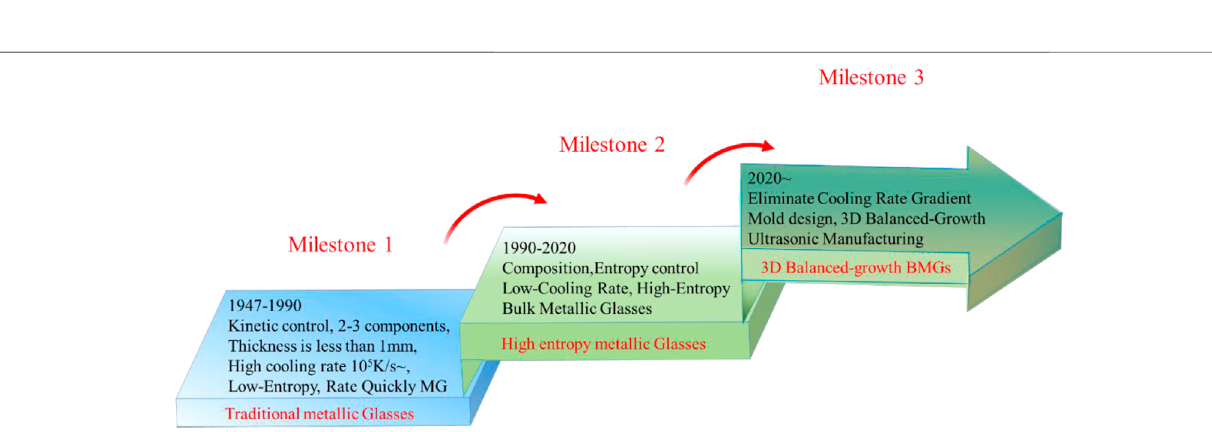
FIGURE 11 | Comparison of the cooling rate gradients of an amorphous alloy growing in a balanced mold and a traditional mold.